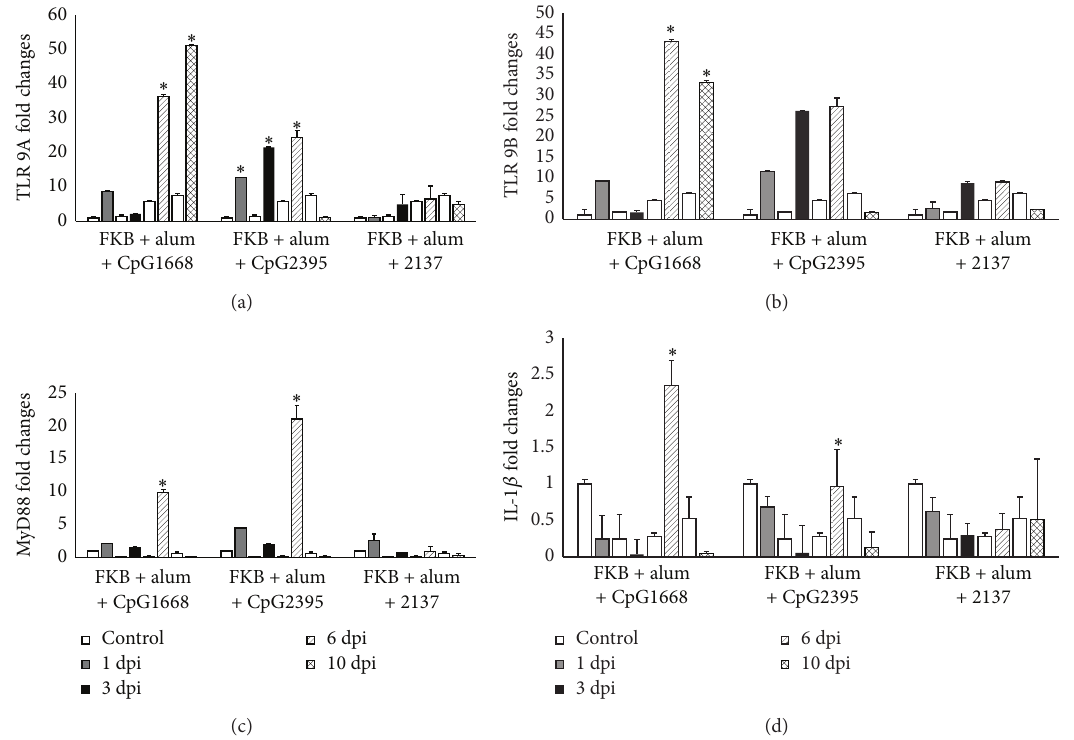
Figure 6: The relative mRNA expressions of (a) TLR9 A, (b) TLR9 B, (c) MyD88, and (d) IL-1 𝛽 in the posterior cobia intestine stimulated with formalin-killed vaccine mixed with CpG and alum and PBS-injected and measured by quantitative real-time PCR. The sampling was carried out at 1, 3, 6, and 10 days after stimulation and 𝛽 -actin was used as a reference gene. The results are presented as the mean ± SD ( 𝑛 = 2 ) and mean values with asterisk ( ∗ ) are significantly different ( 𝑃 ≤ 0.05